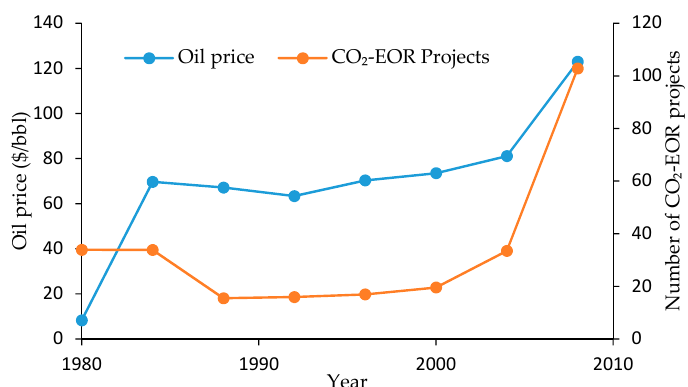
6 of 21 Figure 2. Effect of reservoir temperature and pressure on CO 2 —enhanced oil recovery [32]. 2.3. Economics of CO 2 ‐ EOR The initiation of a CO 2 ‐ EOR project needs capital costs for drilling or reworking wells for both injection and production, the establishment of a CO 2 recycling plant and corrosion ‐ resistant field production infrastructure, the laying of CO 2 capturing pipelines and the purchase of CO 2 . The economics of CO 2 ‐ EOR are therefore highly dependent on several basic factors, including the prevailing oil prices, the reservoir conditions, and the availability of cheap sources of CO 2 . As a result, the economics of CO 2 ‐ EOR vary from country to country, depending on the availability of CO 2 and existing pipeline systems. For example, in the case of USA there are many cheap sources of CO 2 from natural sources ($US 1–2 mmscf/day) and a readily available CO 2 pipeline system, which causes the CO 2 ‐ EOR application to be economically attractive [33,34]. The prevailing oil price also plays a very important role in the economy of the CO 2 ‐ EOR process. Figure 3 shows how the number of CO2 ‐ EOR projects in USA varied with the oil price during the 1980–2008 period. Assuming an average oil price of US$70/barrel, a US government study gave a reasonable cost estimation for CO 2 ‐ EOR, and according to Table 1 [35], the estimated profit is US$30–